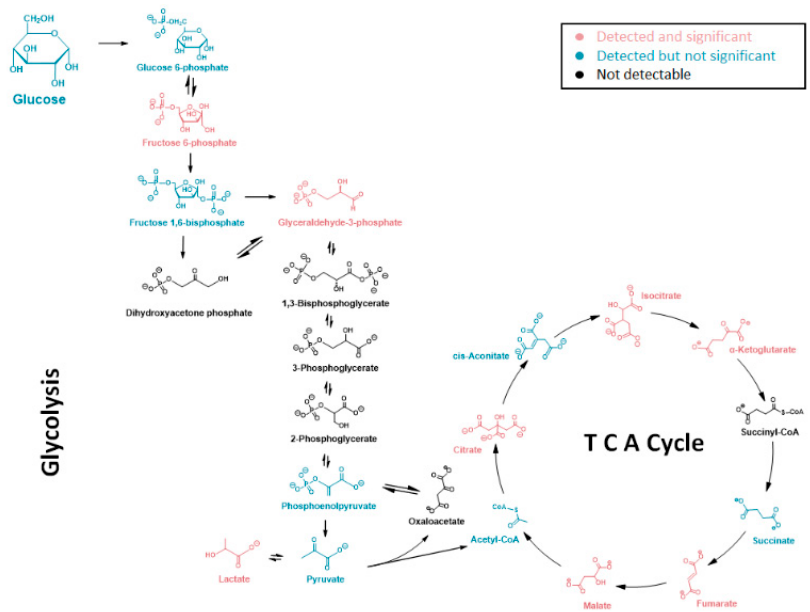
Figure 11. Glycolytic and TCA/Krebs Cycle Metabolites Affected in Their 13 C-Enrichment from Glucose by NAT1 KO in Breast Cancer Cells. Metabolites were detected in the glycolysis and TCA cycle pathways. Metabolites in black were not detected in this study, while the isotopologues of metabolites in pink showed significant abundance changes from NAT1 KO. Isotopologues of the metabolites in blue did not show significant abundance changes.